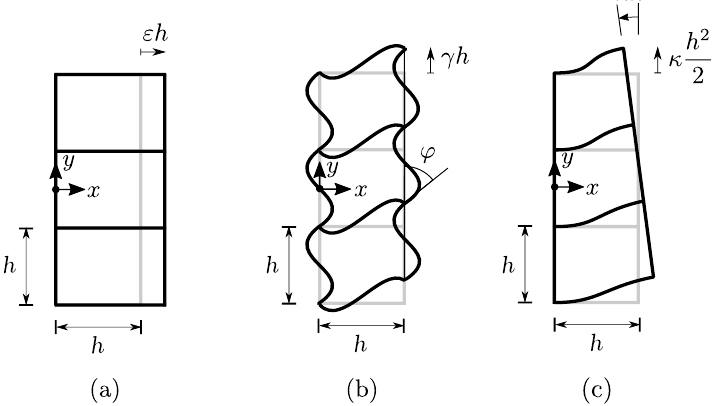
Figure 2. Single cell of the grid beam, and its deformation modes: ( a ) extensional (EX) mode; ( b ) shear (SH) mode; ( c ) flexural (FL)